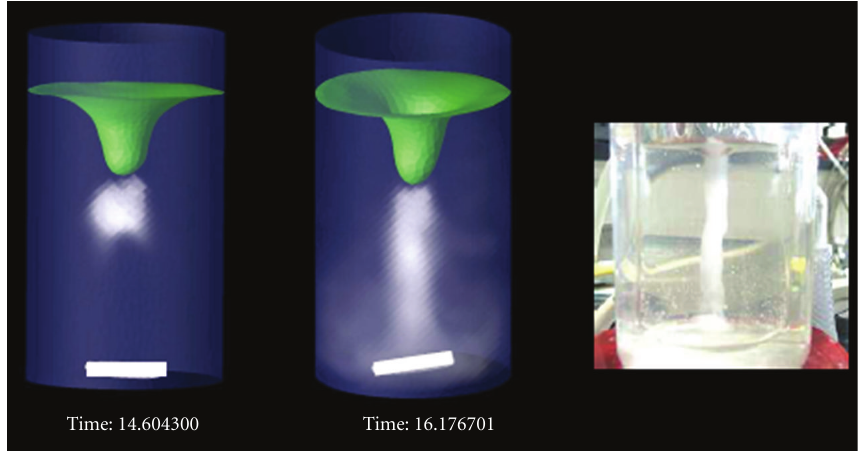
Figure 17: Tracer path-injection into the forced